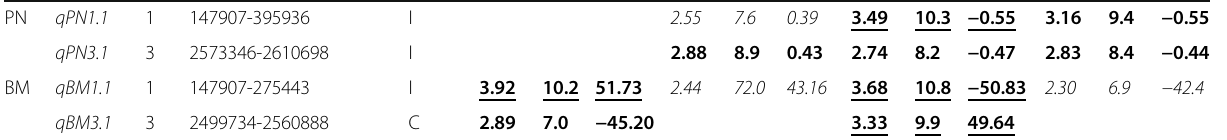
Table 4 QTLs for yield in agronomic traits from a RIL population of Ciherang-Sub1/IR10F365 identified under irrigated control condition (Continued)